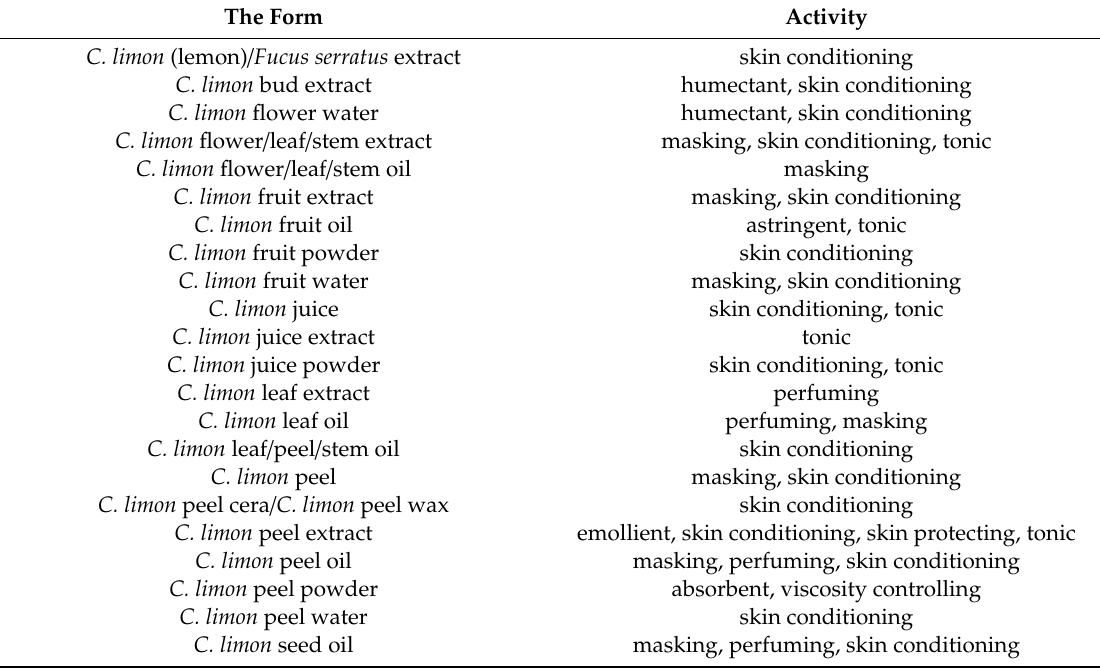
Table 10. C. limon in cosmetic products according to